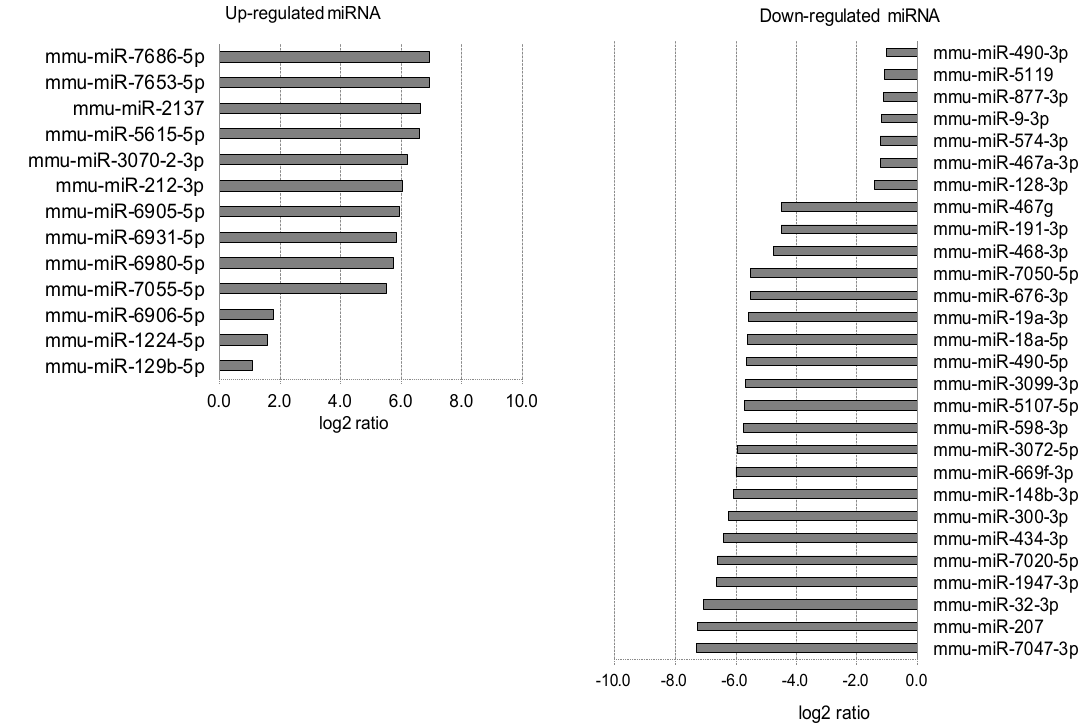
Figure 5. Iris miRNAs affected by myopia induction. The iris miRNAs whose expression was affected by myopia induction are listed as upregulated ( left ) and downregulated ( right ).